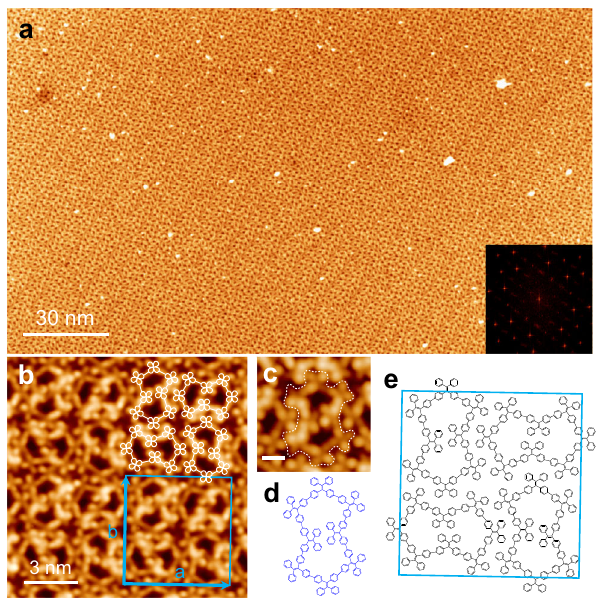
Fig. 4 Eight-membered TPE macrocycles (M8) formed on Ag(111). a Large-scale STM image (200 nm × 120 nm; − 2.0 V, 20 pA) of the 2D crystalline monolayer made of eight-membered macrocycles (M8). Inset: FFT pattern. b Zoom in STM image ( − 1.0 V, 50 pA) of the M8 2D crystal with overlaid simpli fi ed molecular models. The blue square denotes the unit cell. c , d High-resolution STM image ( − 1.0 V, 150 pA) and chemical model of M8, outlined by the dashed white line. Scale bar: 1 nm. e Schematic model of the M8 2D